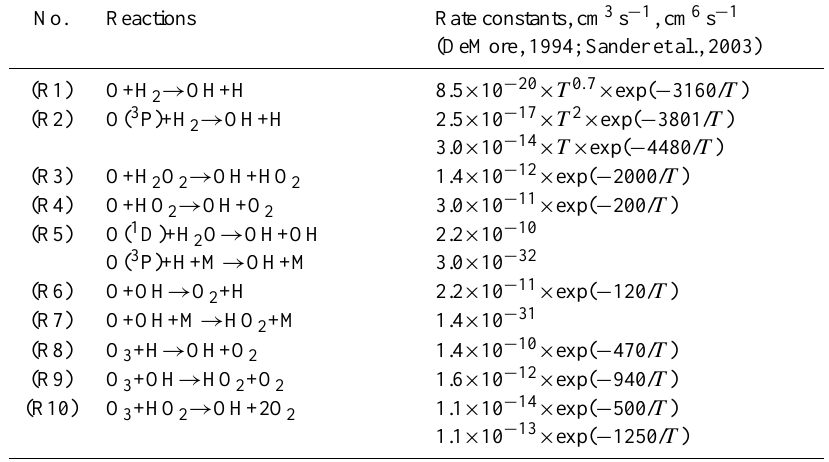
Table 2. Reactions of odd oxygen with hydrogen species in the mesosphere.